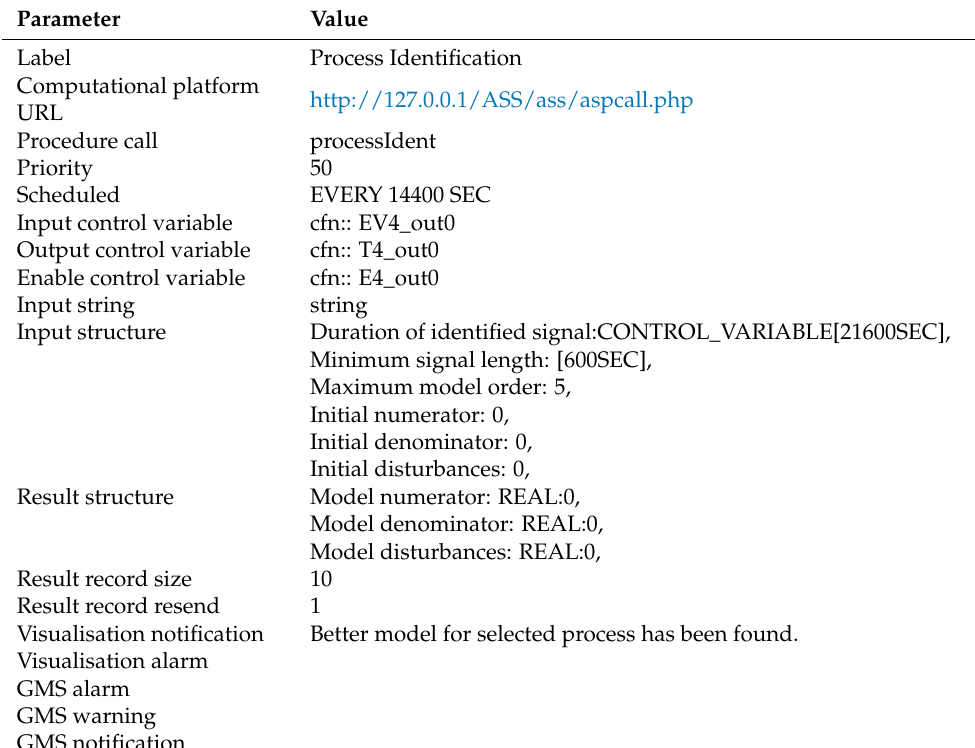
Table 3. Experimental setup for the processIdent()